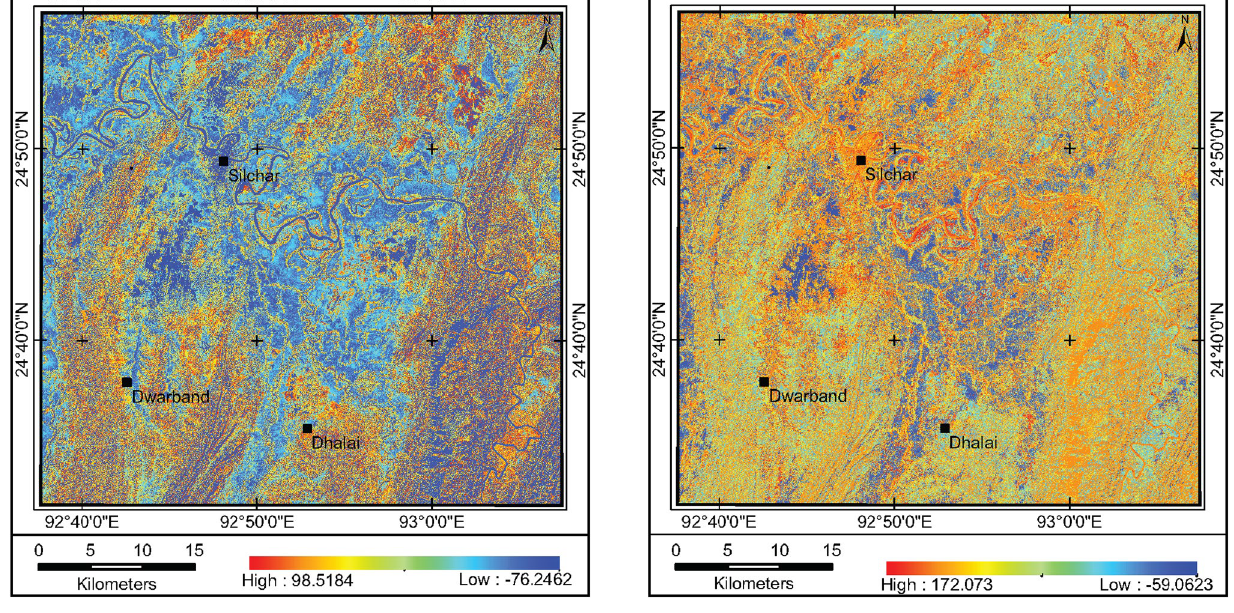
Fig. 6 PC image 3457PC4 representing clay and carbonate mineral- rich areas as low pixel values